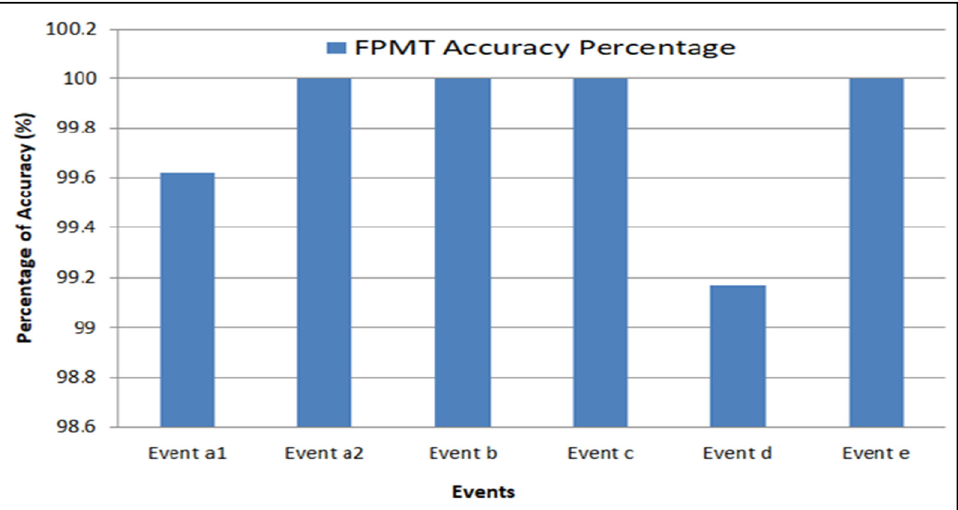
Figure 17. FPMT measurement accuracy.